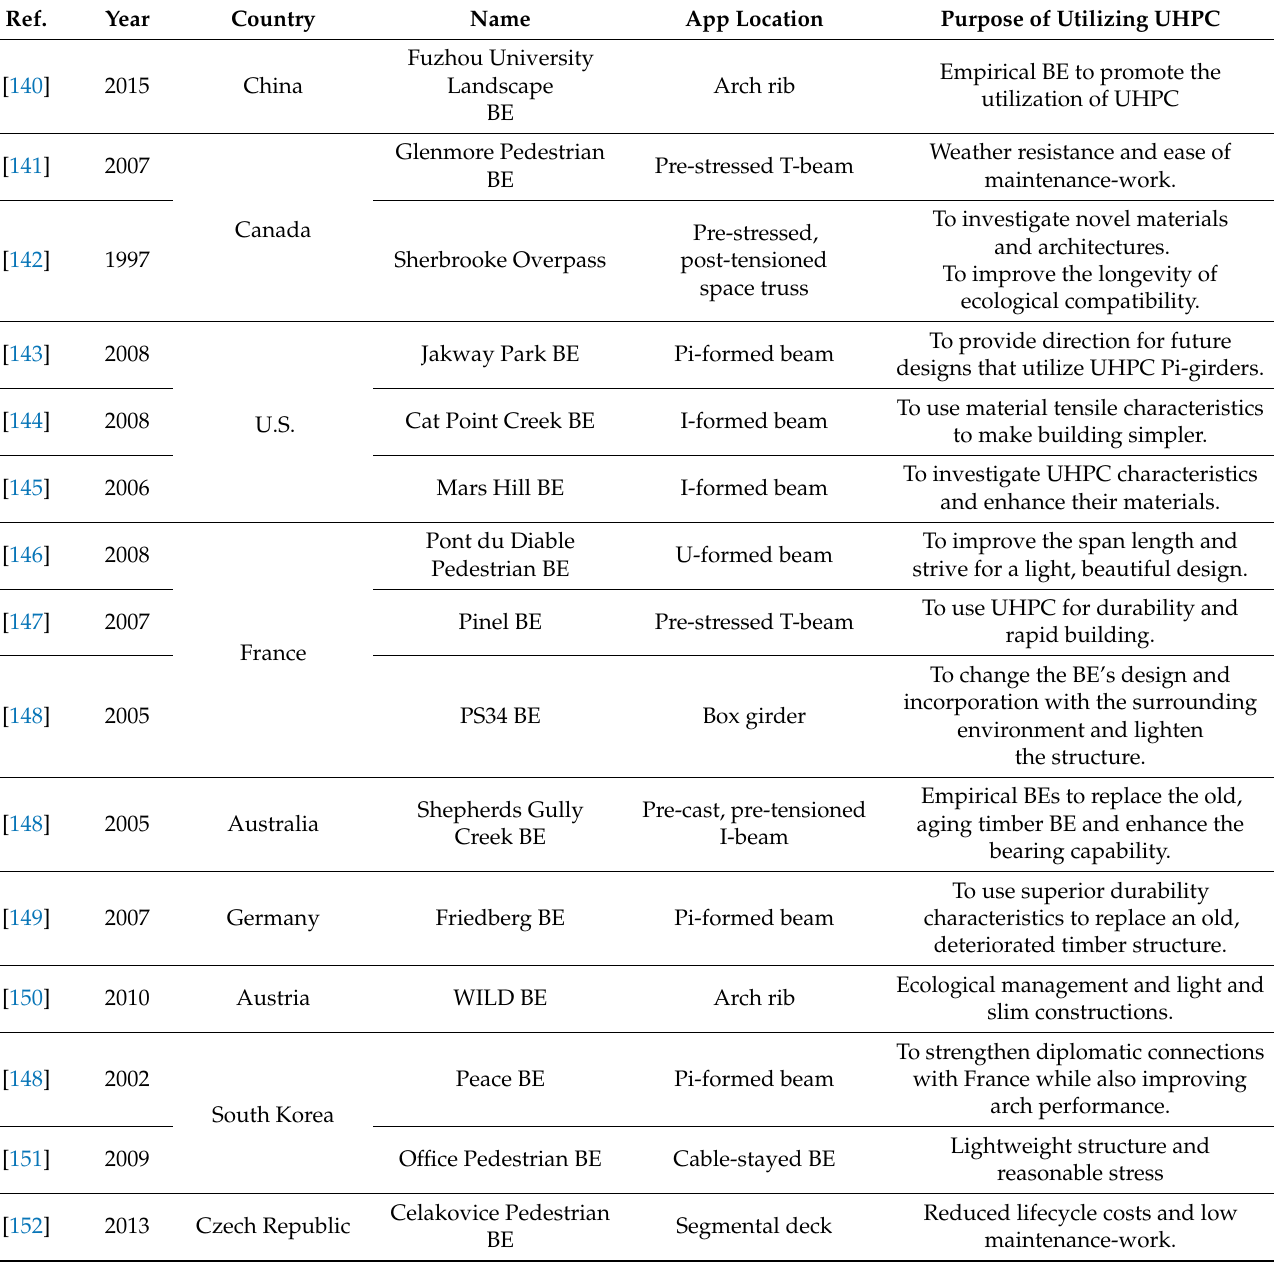
Table 6. Examples of UHPC apps in BE bearing components.